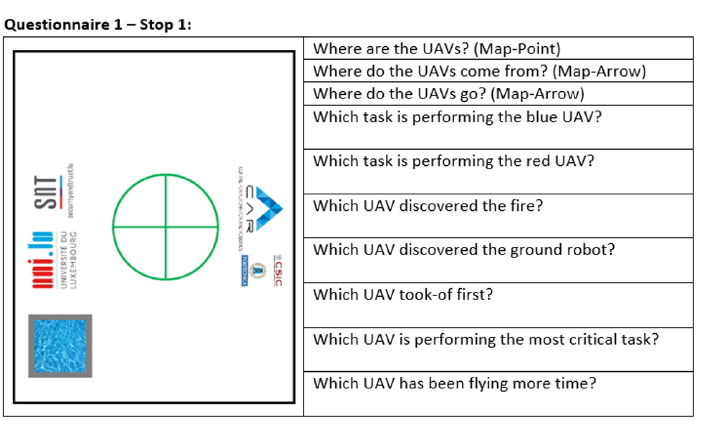
Figure 14. Situation awareness global assessment technique (SAGAT): English translation of the questionnaire of the experiments.